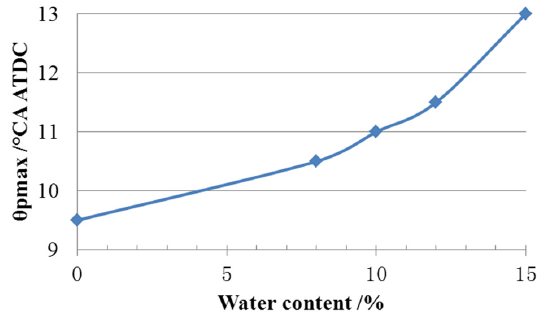
Figure 13. Variation tendency of θ pmax according to water content in fuel.